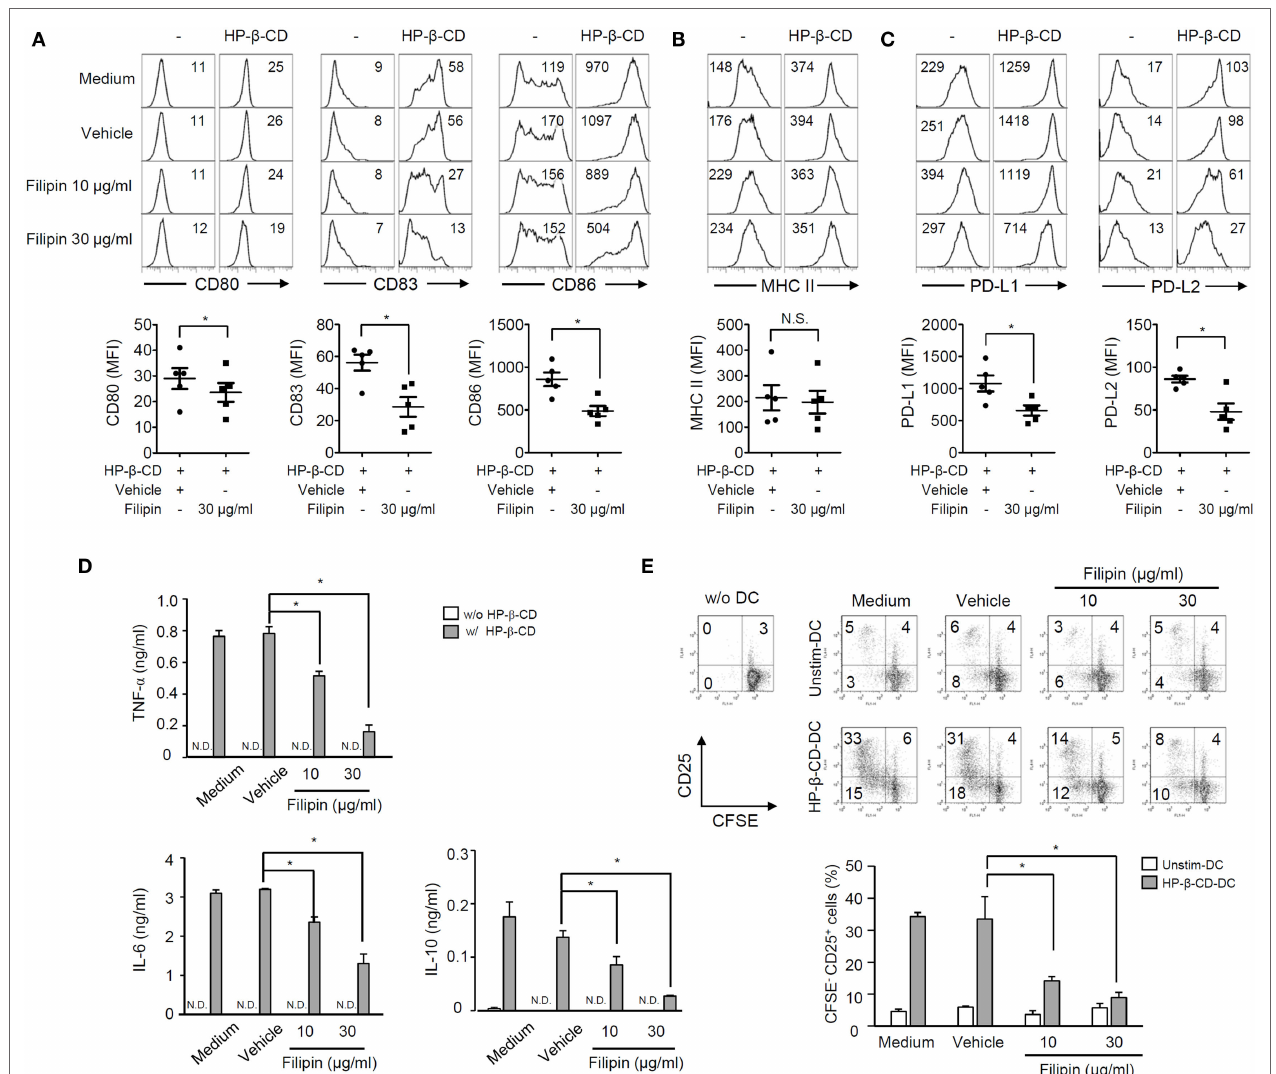
FigUre 4 | inhibition of lipid raft formation attenuates Dc maturation, cytokine production, and autologous T cell activation induced by hP- β -cD . Human monocyte-derived DCs (2.5 × 10 5 cells/ml) were pretreated with filipin (10 and 30 μ g/ml) or methanol as a vehicle control for 1 h, followed by stimulation with HP- β -CD (1 mg/ml) for another 24 h. (a–c) The expression of costimulatory molecules, MHC class II, and PD-L1/L2 was analyzed by flow cytometry. The numbers on the histograms indicate the MFIs of the cells. Scatter plots under the histogram show MFI of DCs ( n = 5). Statistical differences between compared groups were analyzed by paired Student’s t -test. N.S., not significant; * P < 0.05. (D) The concentrations of TNF- α , IL-6, and IL-10 in the supernatants were measured by ELISA. (e) Unstimulated or HP- β -CD-stimulated DCs (5 × 10 4 cells) were cocultured with CFSE-labeled autologous T lymphocytes (5 × 10 4 cells) for 5 days. The levels of proliferation and CD25 expression of the T lymphocytes were analyzed by flow cytometry. The numbers on the histograms indicate the percentages of cells in each quadrant. The bar graph below the histograms displays the average of triplicate measurements ± SD for the frequencies of CD25 + T lymphocytes with proliferative ability. Unstim.-DC indicates T lymphocytes cocultured with unstimulated DCs. Results shown are representative of three independent experiments. Statistical differences between compared groups were analyzed by Student’s t -test. N.D., not detected; * P <